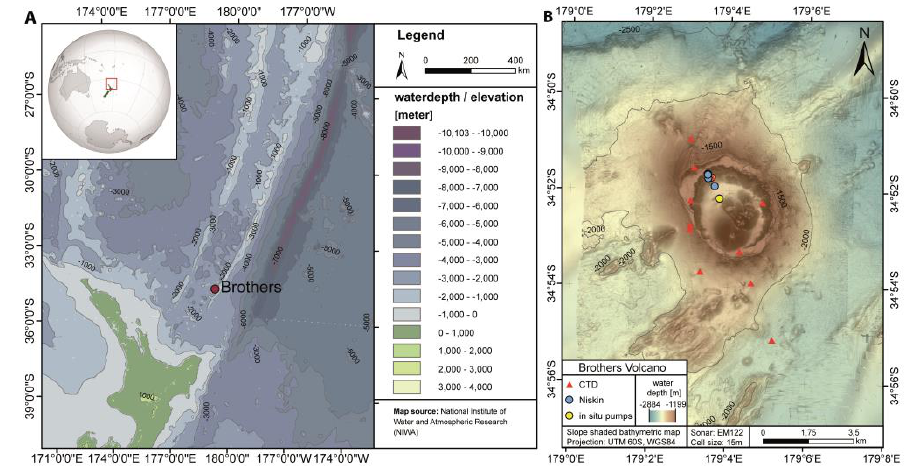
Figure 1. ( A ) Overview map of the southern Kermadec intraoceanic arc near the Northern Island of New Zealand. The map source is provided by the National Institute of Water and Atmospheric Research, New Zealand (NIWA) [52]. The scale is 1:12,000,000 and the map uses the UTM Zone 60S projection. The map and figure captions were taken from Neuholz et al. [39]. ( B ) Local bathymetry map of Brothers volcano with marked sample locations based on multibeam data from SO253 cruise [53]. Note that due to the map section the 083_TMR station (Appendix A.2 Table A1) NW of Brothers is not displayed here.